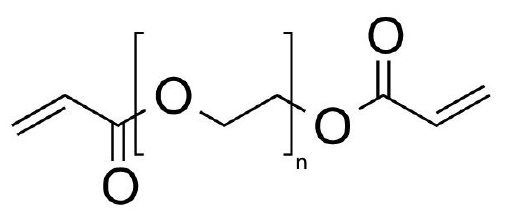
Figure 1. Representation of the Polyethylene Glycol Diacrylate (PEGDA) chemical structure in which n represents the ethylene glycol repetition unit and the extremes are acrylate groups.